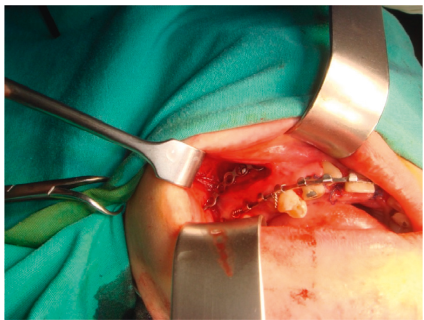
Figure 3: Intraoperative condylar positioning device on right maxilla. This procedure was completed bilaterally prior to the surgery on the mandible in stabilizing the proximal segments